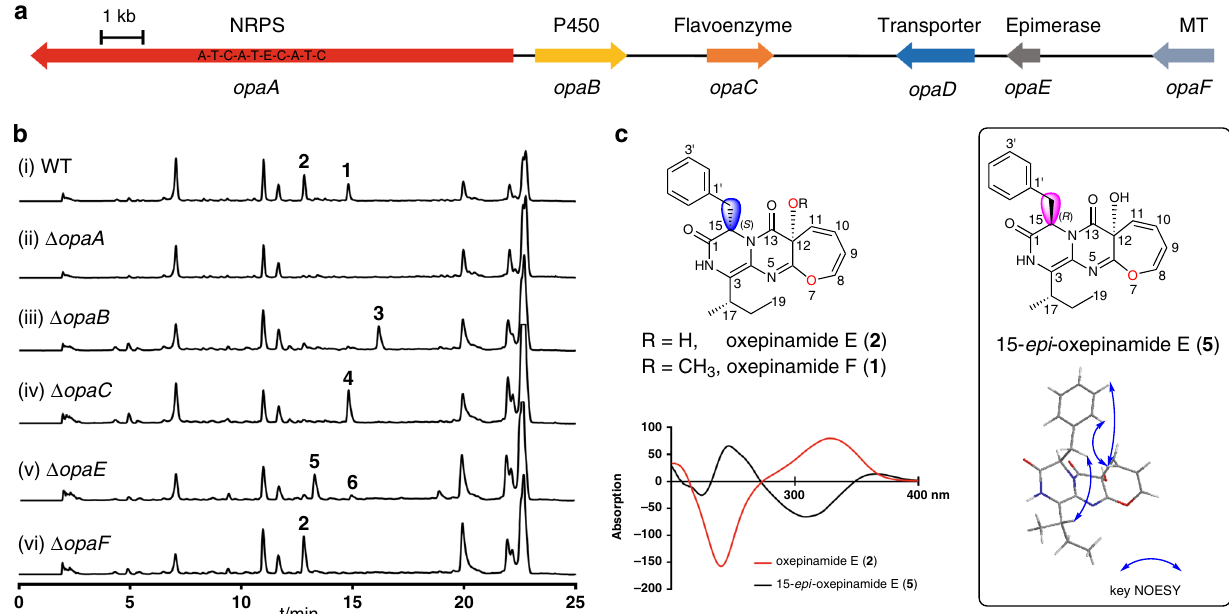
Fig. 2 Biosynthetic genes of oxepinamide F and intermediates. a The oxepinamide biosynthetic gene cluster ( opa ) from A. ustus 3.3904. b HPLC analysis at 254 nm of the extracts after 7 day cultivation. c Structures of oxepinamide F ( 1 ), E ( 2 ), and 15- epi -oxepinamide E ( 5 ), as well as the CD spectra of 2 and 5 (200 – 400 nm). Blue double-headed arrows represent NOESY